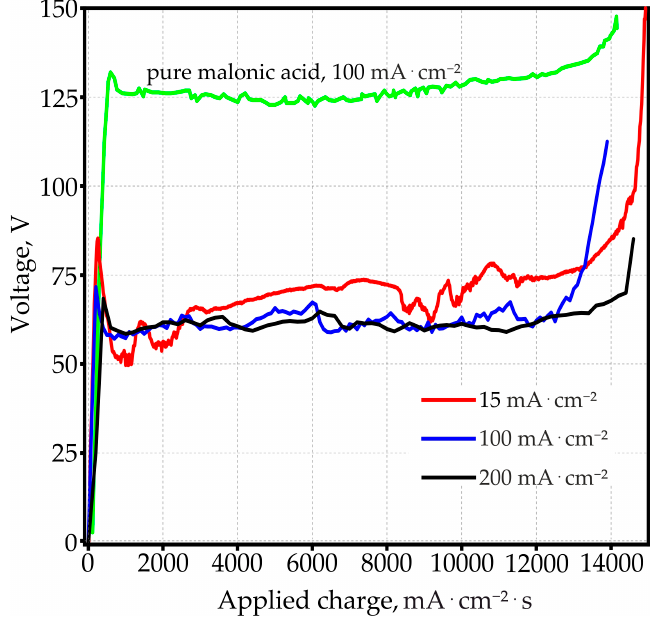
Figure 3. Dependence of anodic voltage on applied charge during galvanostatic anodizing in 0.6 M malonic acid pure and with 3.5 g·L − 1 arsenazo-I additive at anodic current densities 15, 100, and 200 mA·cm –2 .